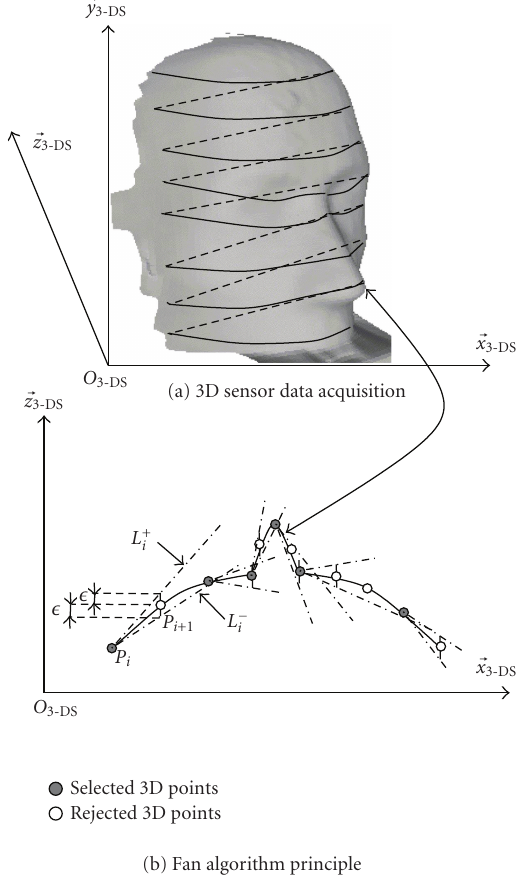
Figure 5: Data down-sampling